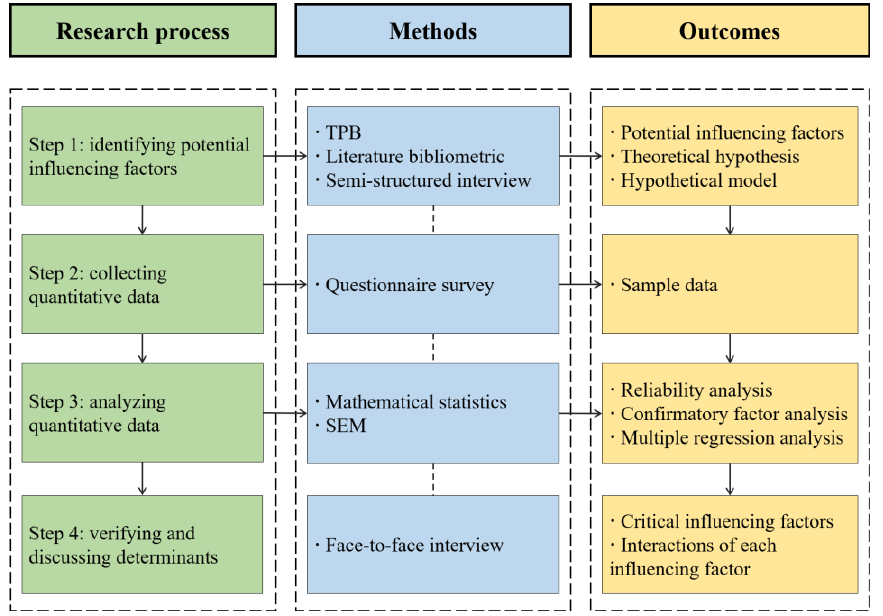
Figure 2. The research process.